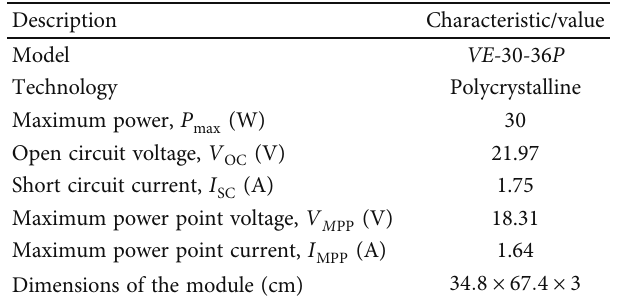
Table 2: Speci fi cation of the photovoltaic (PV) module.